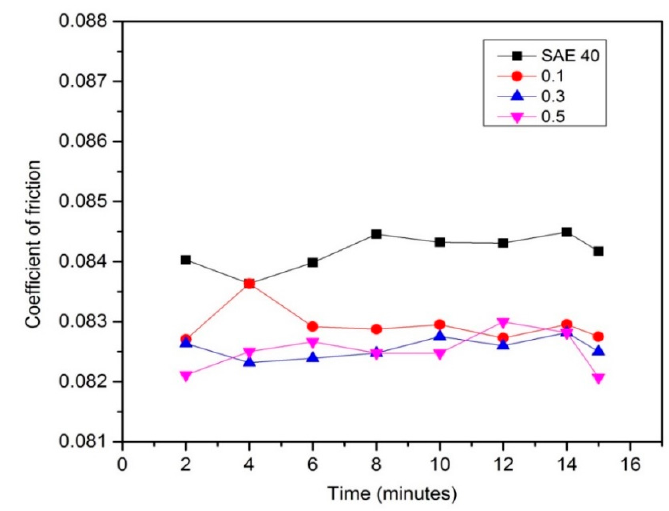
Figure 14. COF results for lubricant sample at low-speed high load.